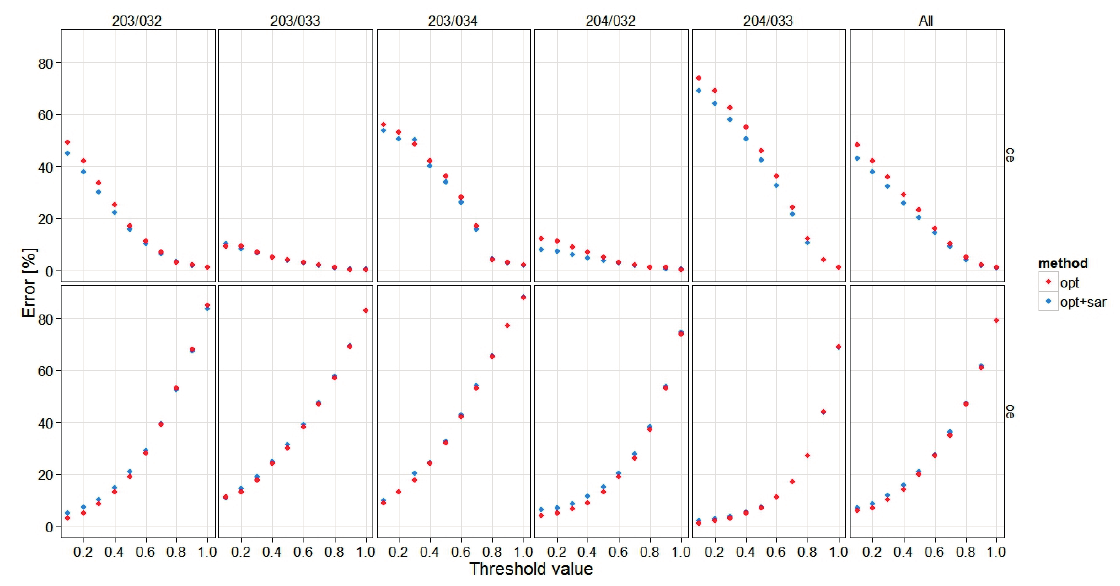
Figure 10. The commission (top row) and omission (bottom row) errors (%) as a function of the threshold applied to the fuzzy score map, derived with only optical (red markers) and optical + SAR data (blue), for each TM frame and for the study area as a whole (last column). Notice that the commission (omission) errors in the optical + SAR maps are 43.1% (6.8%) and 20.1% (20.8%) for threshold values of 0.1 and 0.5, respectively. On the contrary, in the case in which only optical data are used, the corresponding values of 47.9% (5.7%) and 22.6% (19.6%) are